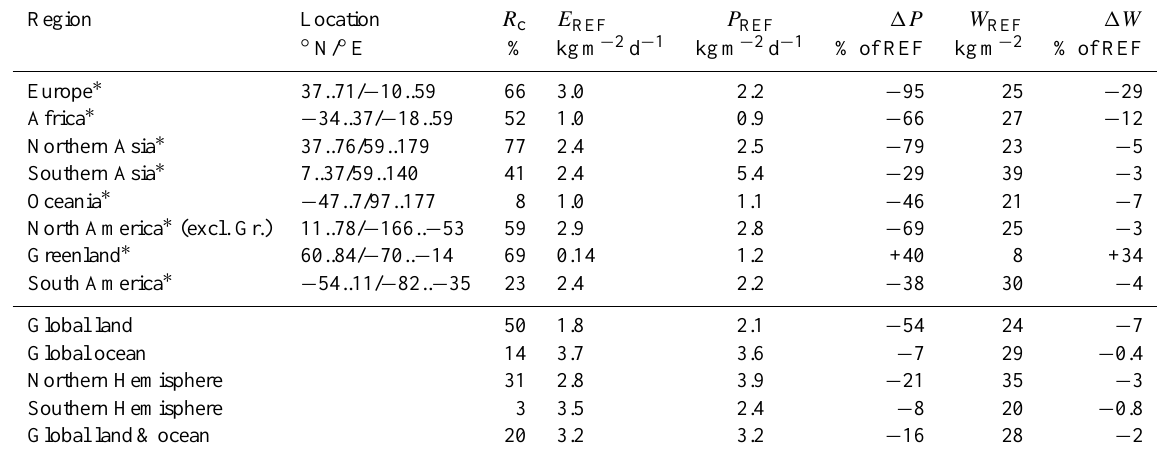
Table 1. Areal mean (July) continental recycling ratio ( R c ), evaporation ( E ), precipitation ( P ), and precipitable water ( W ) in the REF experiment, the response of P and W to the suppression of land-evaporation (DRY-REF), and 1 P in relation to the imposed evaporation decrease ( 1E = E REF , valid for land